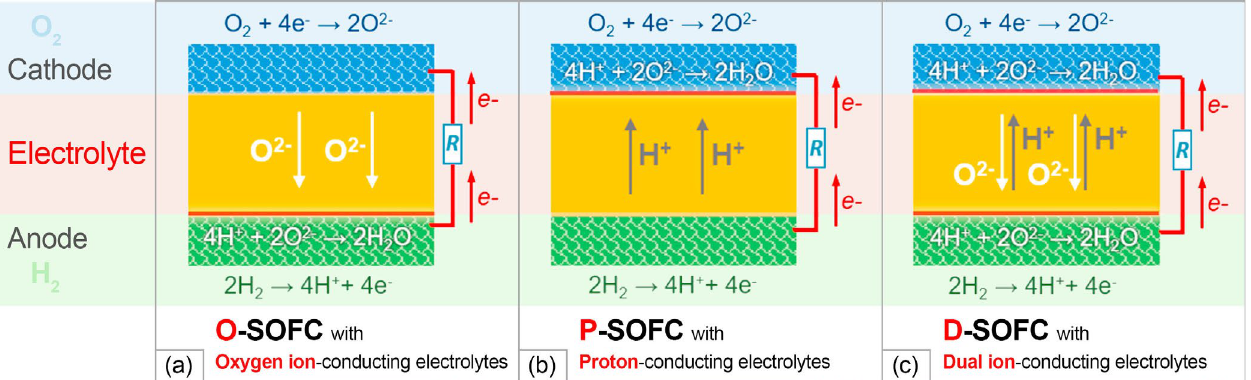
Figure 11. Schematic representation of SOFCs: ( a ) with an oxygen ion-conducting electrolyte; ( b ) with a proton-conducting electrolyte; ( c ) dual-conducting electrolyte (adopted from [135]). A solid-state electrolyte is a key part of a SOFC and it should meet some very im-